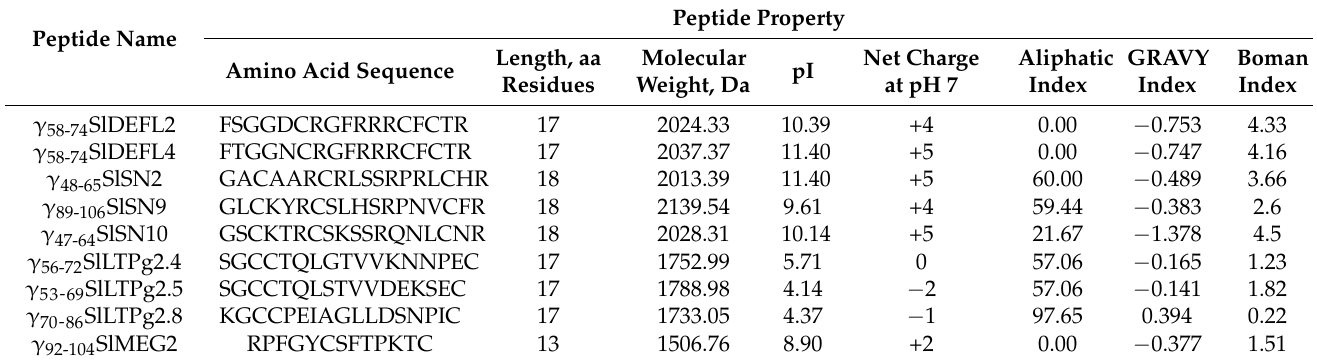
Table 1. Physicochemical properties of the synthetic peptides.